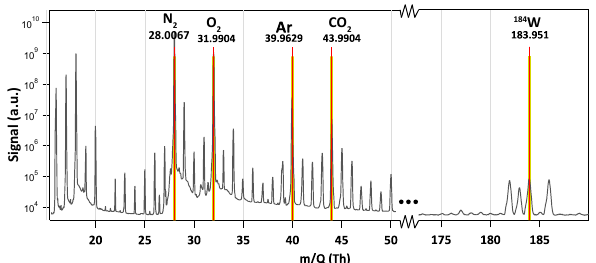
Fig. 2. Raw mass spectrum of the ToF-ACSM (logarithmic scale). The x axis is interrupted between m/Q = 50Th and 175Th to show all peaks used in the mass-to-charge calibration. The cali- bration peaks are as follows: nitrogen (N 2 : 28.0067Th), oxygen (O 2 : 31.9904Th), argon (Ar: 39.9629Th), carbon dioxide (CO 2